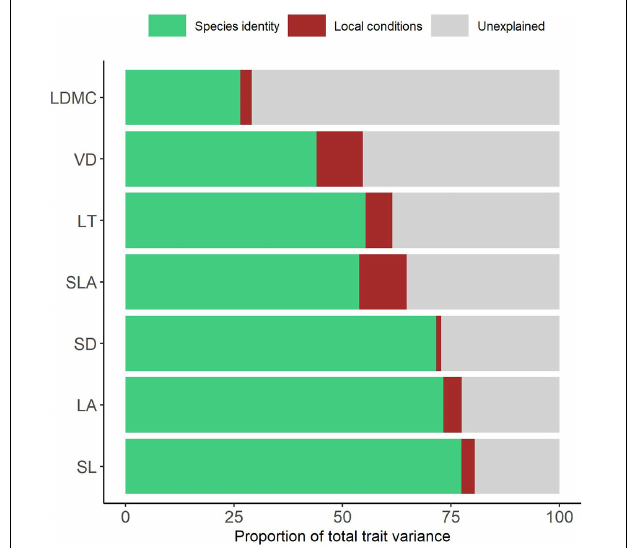
FIGURE 2 | Partitioning of variance for each leaf trait into local conditions (plot), species identity and unexplained (residual). Leaf traits are sorted from low to high unexplained variation. LDMC, leaf dry mass content; VD, venation density; LT, leaf thickness; SLA, specific leaf area; SD, stomata density; LA, leaf area; SL, stomata